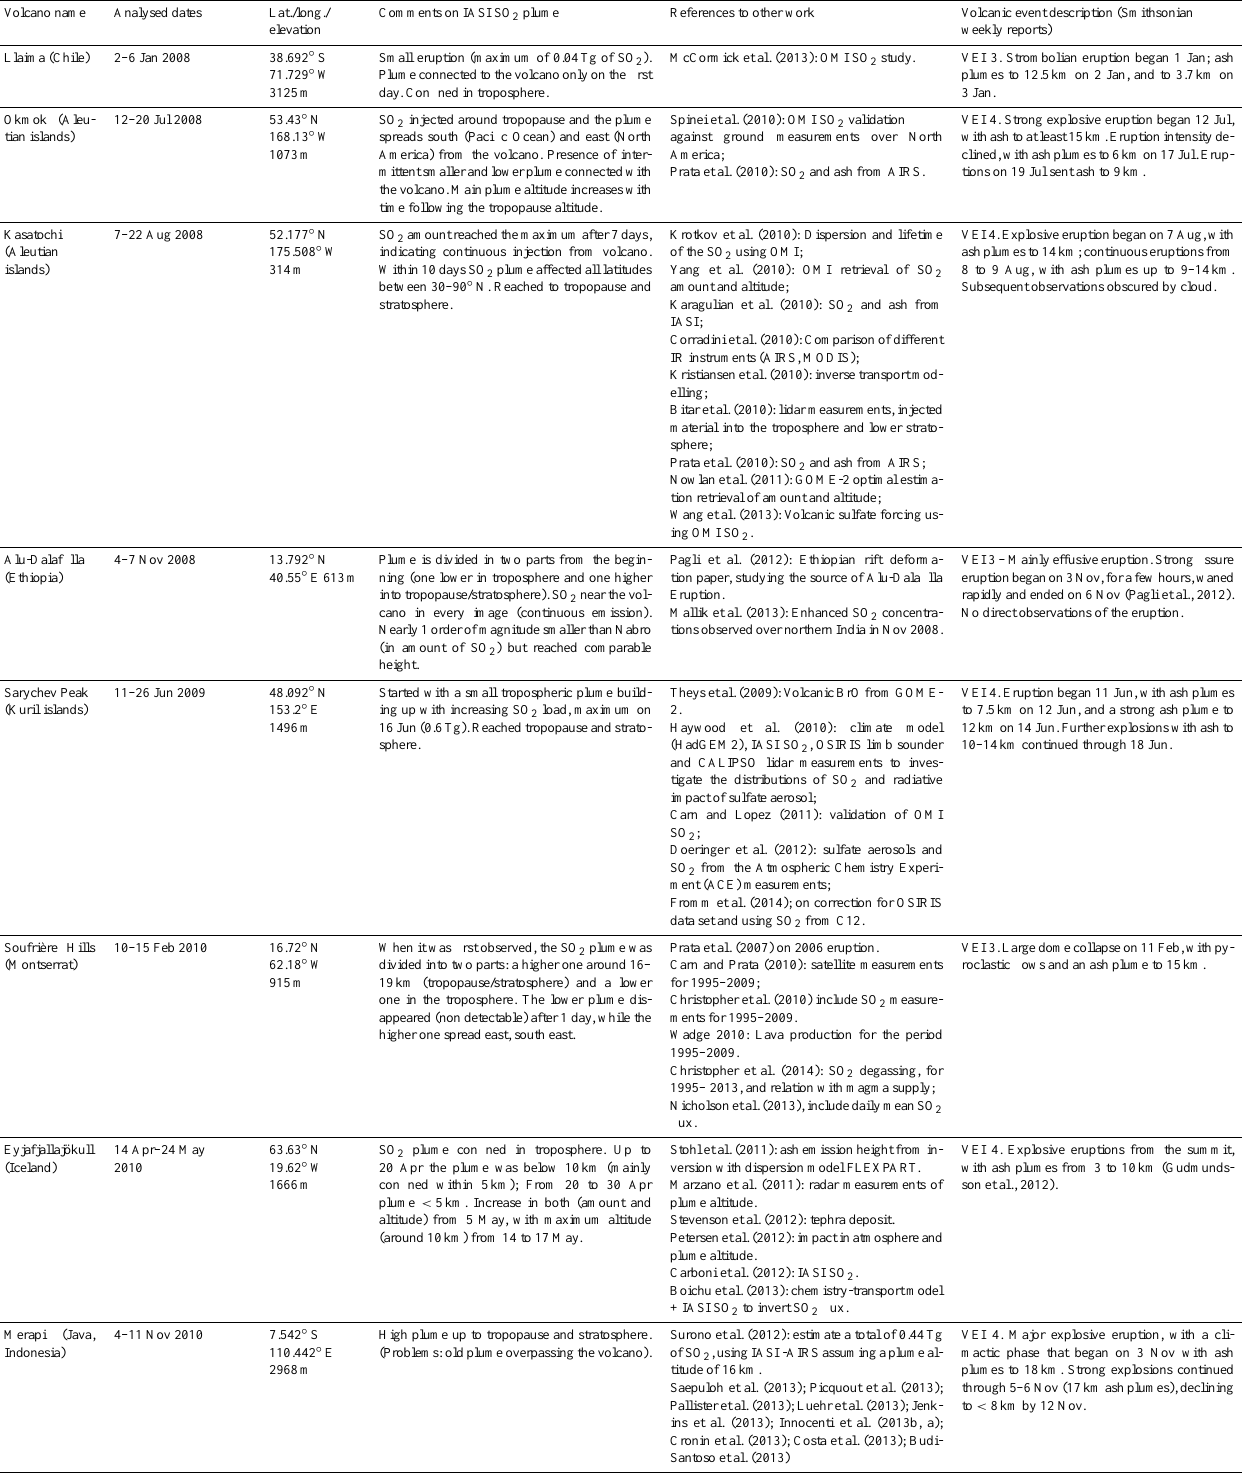
Table 1. Summary of studied eruptions, in chronological order, together with other relevant literature, volcanic explosivity index (VEI) and a short descriptions of the events from the Smithsonian Institution Global Volcanism Programme website (http://www.volcano.si.edu). Volcanoname Analyseddates Lat./long./